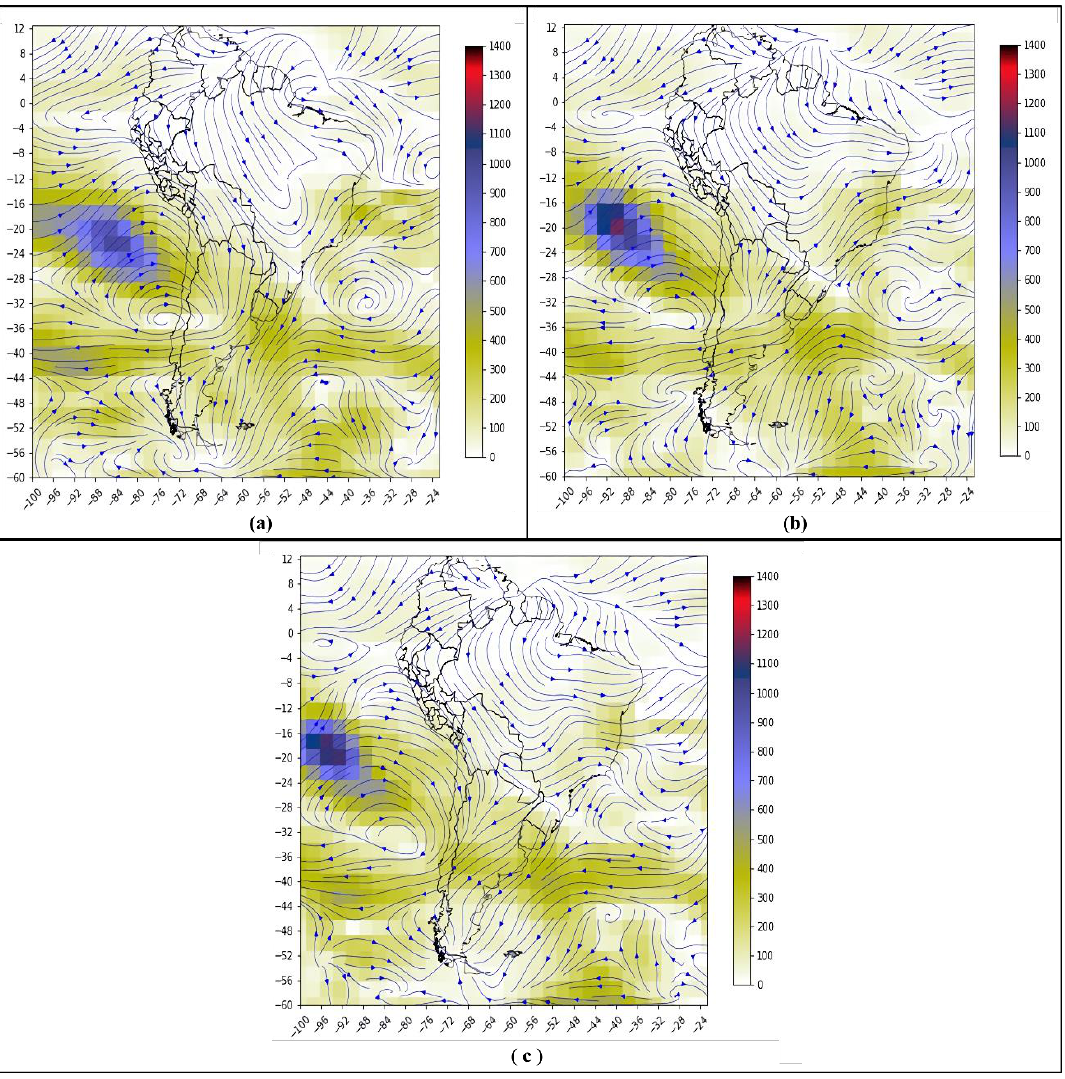
Figure 16. Horizontal vector flow of vertically integrated total column of water vapor flux (kg m −1 s −1 ) during the rainfall event of 15 January 1970; calculated between 1000 hPa and 300 hPa for ( a ) 12 UTC (07 LT), ( b ) 18 UTC (13 LT), and ( c ) 00 UTC (19 LT). The geographic boundaries of South America and Peru are indicated. All fields were obtained from NCAR reanalysis data with 2.5-degree spatial resolution.